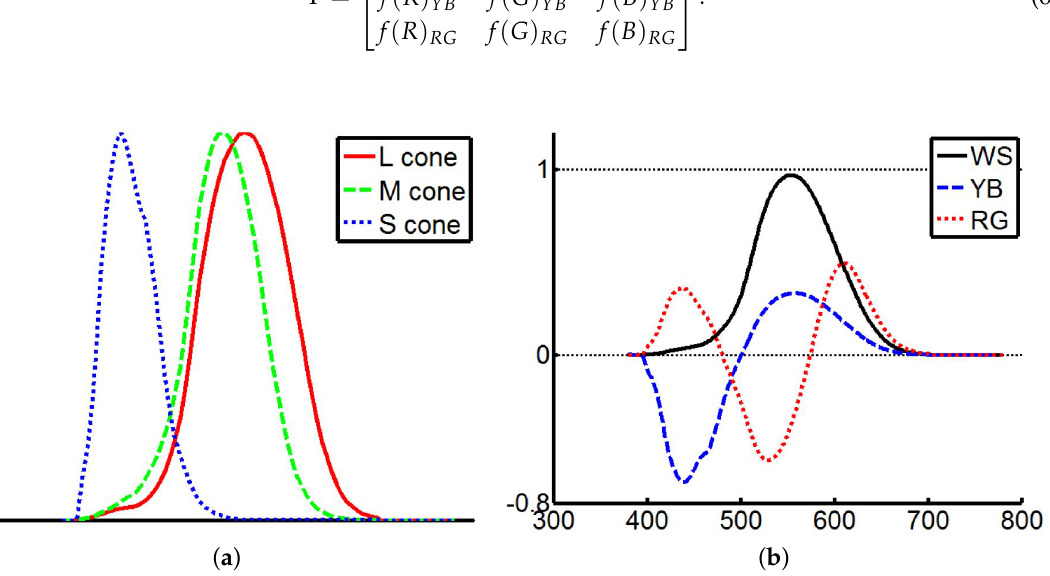
Figure 3. The cone spectral sensitivity functions at all wavelengths in the visible range. ( a ) Responding curve [36]. ( b ) Spectral response functions for the opponent channels